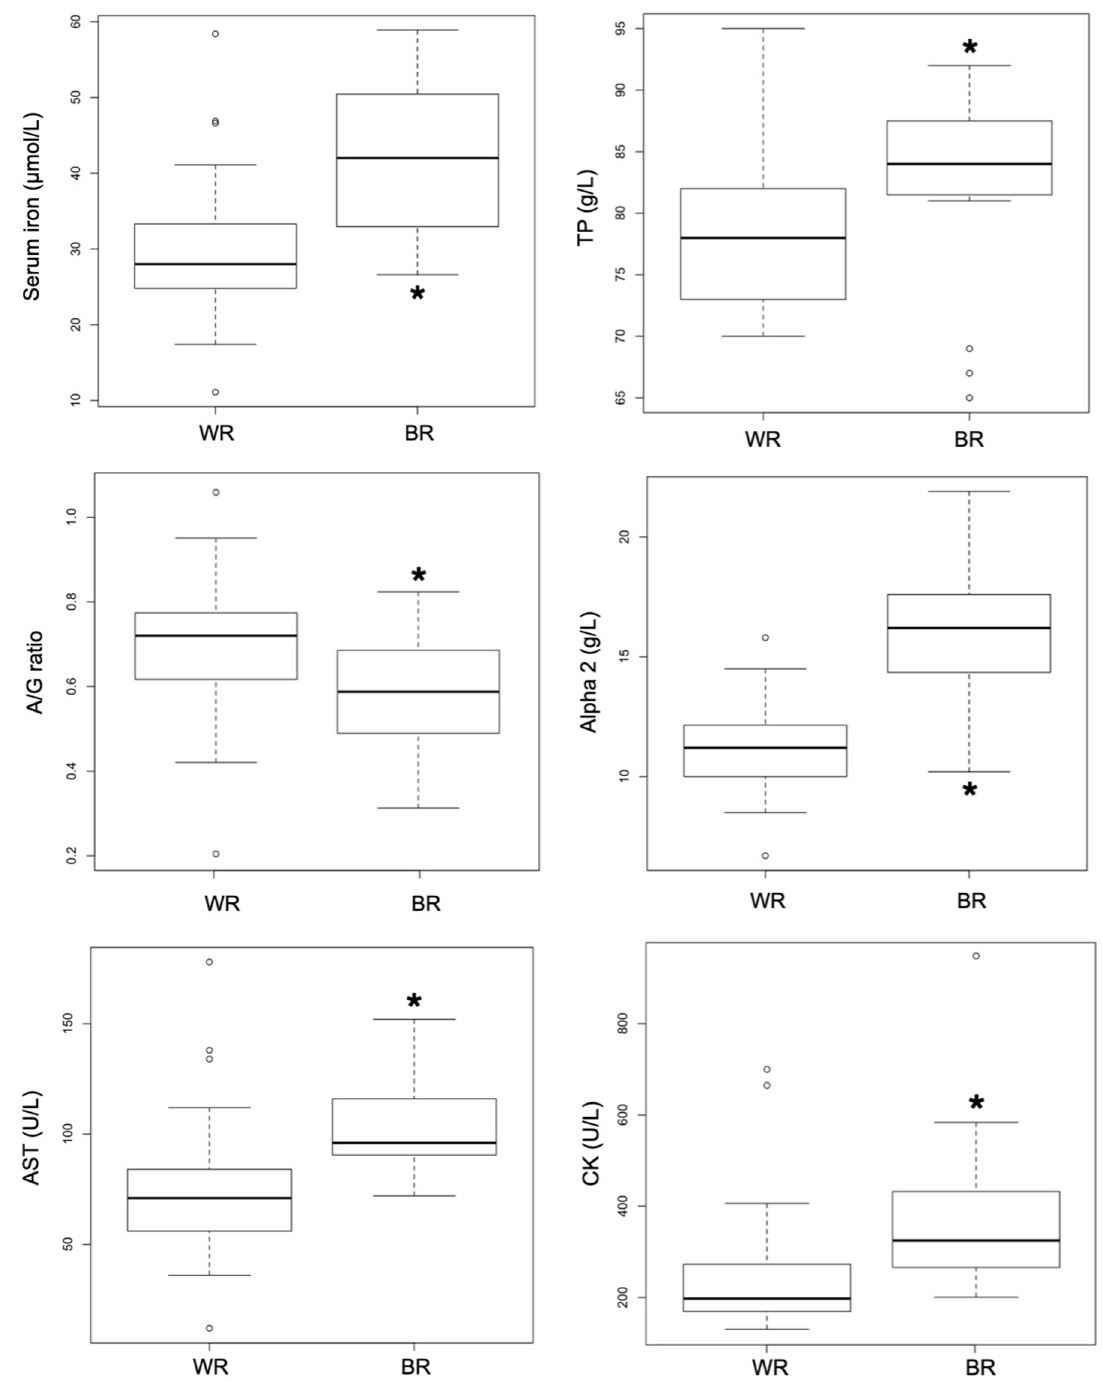
Fig 1. Boxplots showing the quartiles and outliers of serum iron, TP, A/G ratio, α 2 -globulins AST, and CK results in 15 European captive black rhinoceroses (BR) and 29 white rhinoceroses (WR). Values were significantly different between the species in all cases (P <